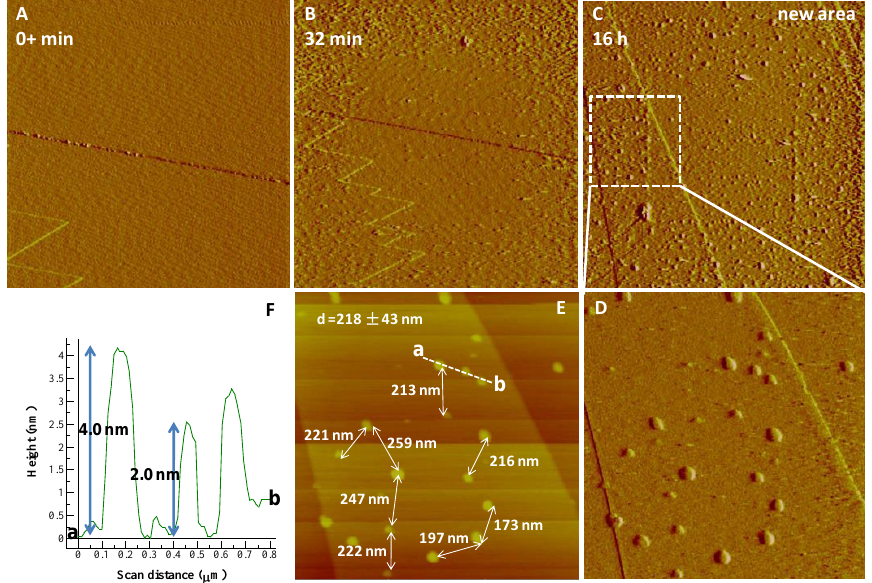
Figure 4. AFM time sequence (deflection images) showing in situ nucleation kinetics of Fe-P phases on a dissolving goethite surface in 50 mM NH 4 H 2 PO 4 (pH 2.0) at ( A ) t = 0 min, ( B ) 32 min, and ( C ) 16 h, respectively. ( D ) A zoom of a dotted rectangle in ( C ) showing Fe-P nanoparticles on a goethite (010) cleavage face and ( E ) inter-particle distances (218 ± 43 nm). ( F ) Height profile for Fe–P nanoparticles on a goethite (010) cleavage face along section a → b (dashed line in ( E )). The average height of Fe-P nanoparticles is about 2.0–4.0 nm. AFM images, ( A ) 5 μm × 5 μm; ( B , C ) 10 μm × 10 μm; ( D , E ) 3 μm × 3 μm.